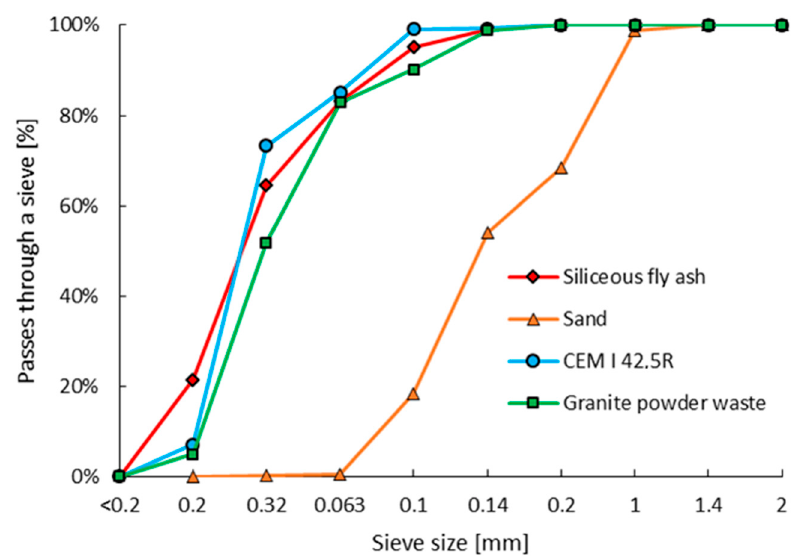
Figure 2. Sieve size development of granular materials used in this research.